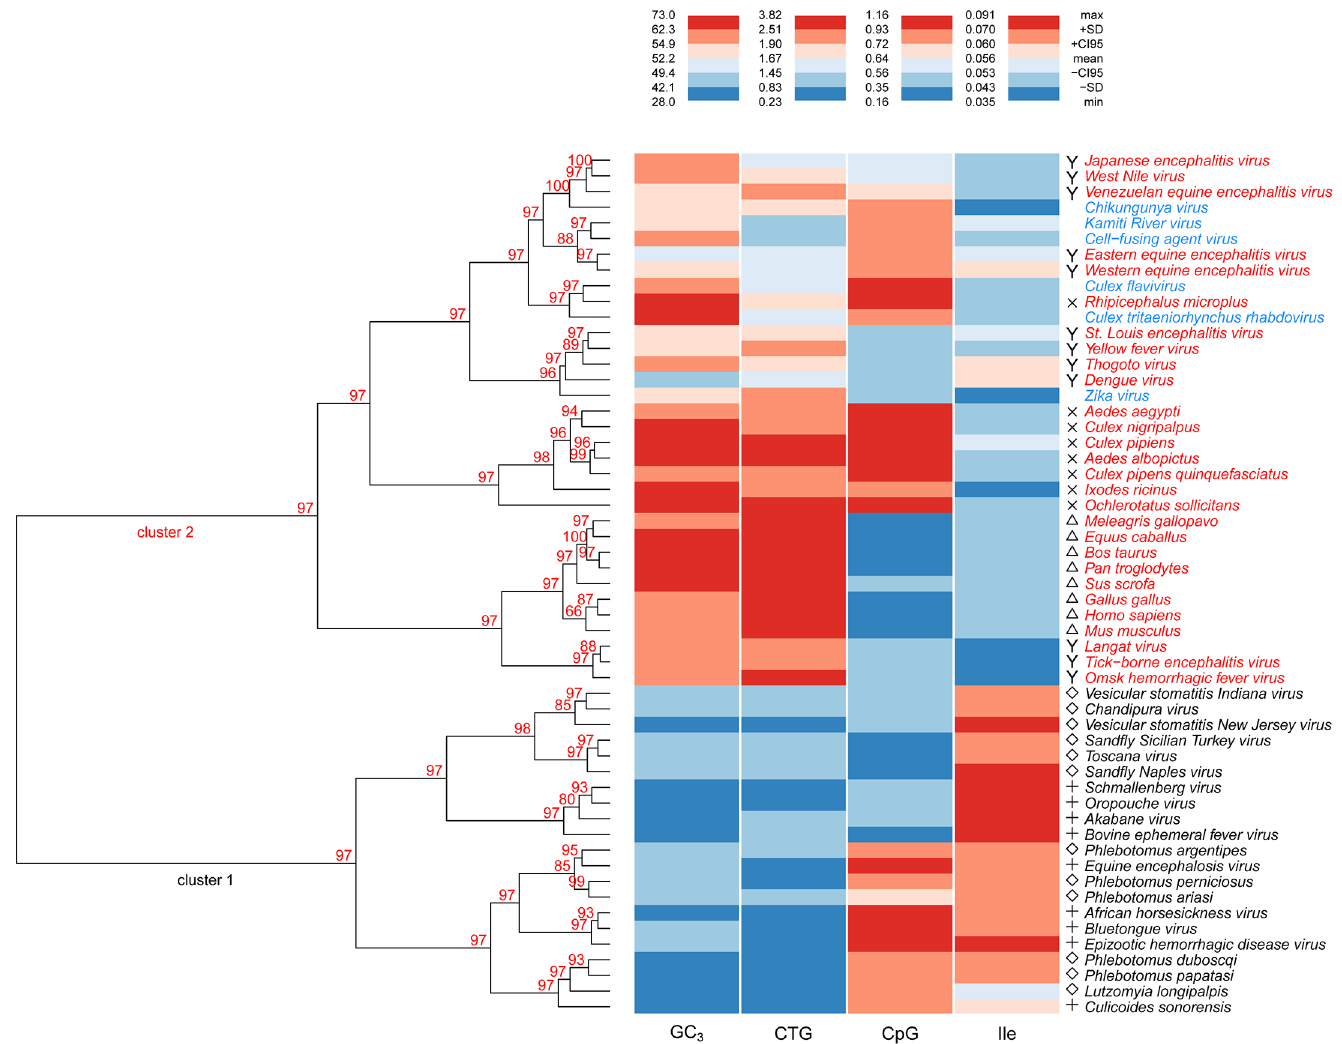
Fig 6. Inferring arbovirus host preferences. A two way hierarchical cluster analysis (Euclidean distance, Ward ’ s D clustering) was conducted using some of the relevant markers identified in this study (GC 3 , CTG, CpG, Ile). The cluster relationship was congruent with the current biological information regarding to the different infectious cycles of these viruses. The AU p-values from a multiscale bootstrap analysis (n = 10000) are overlaid over the dendrogram Viruses with blue labels represent new viruses included to assess the reliability of this analysis.